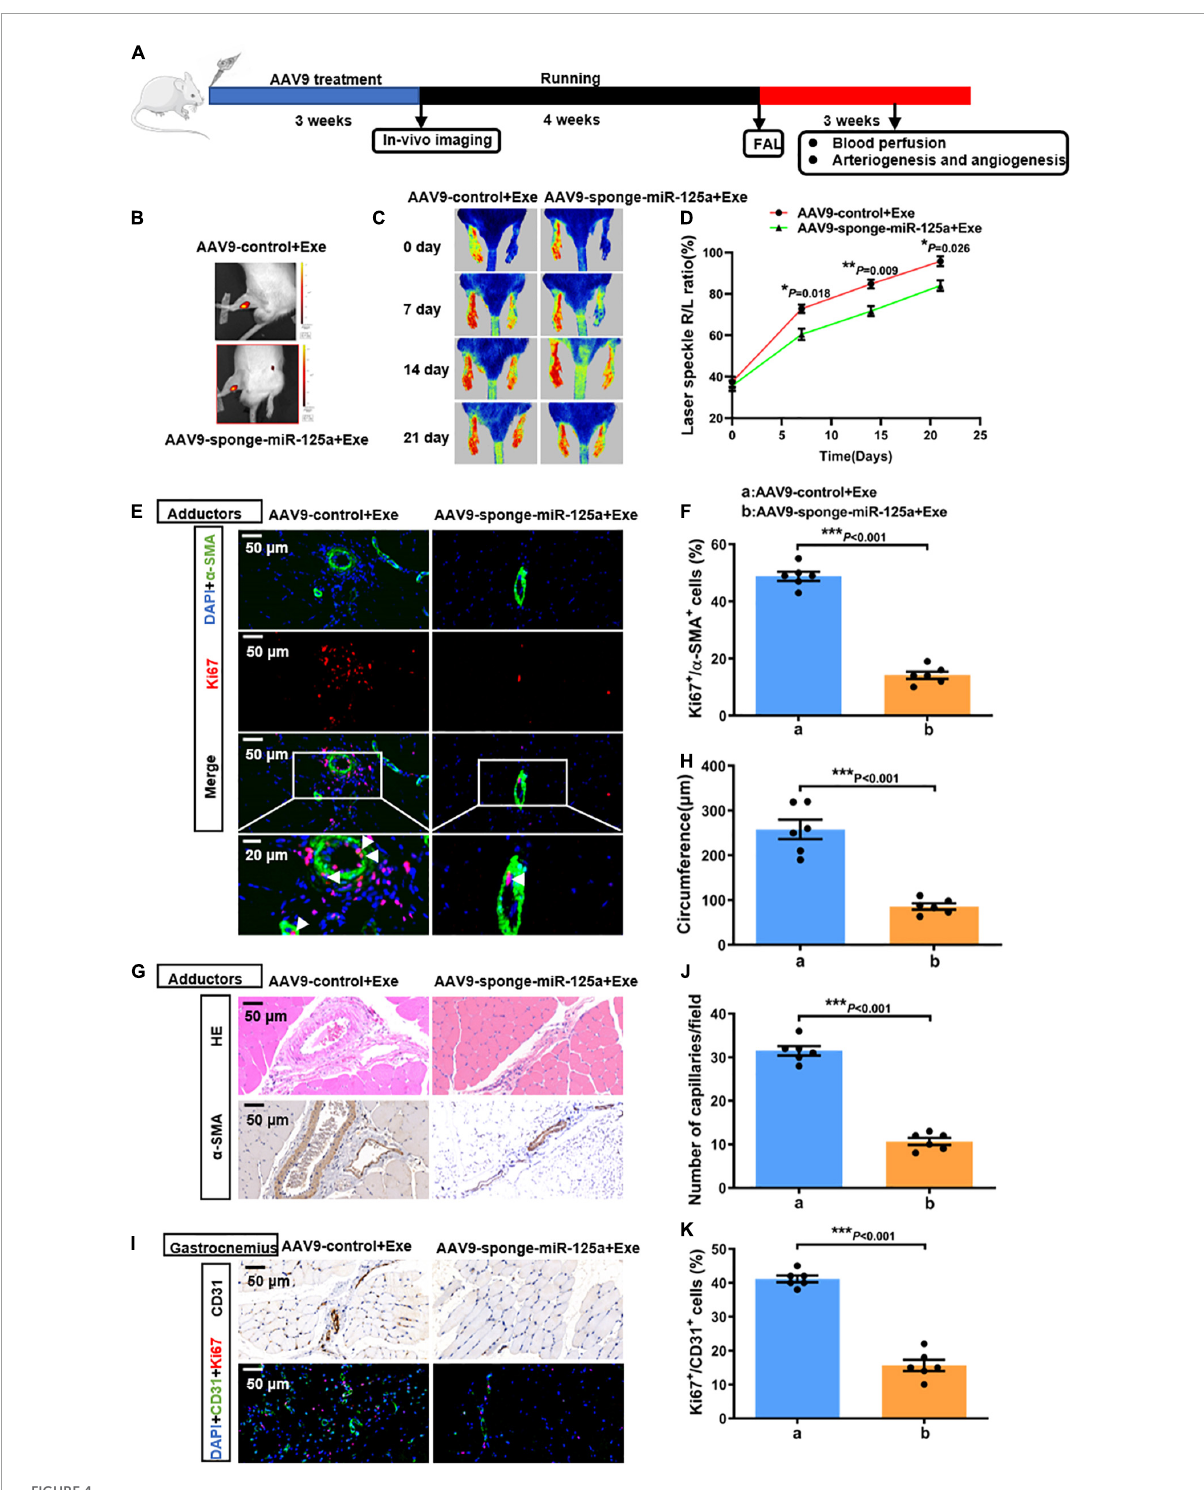
FIGURE4 miR-125a-5p was indispensable in exercise-induced arteriogenesis and angiogenesis in vivo . (A) Rats were randomly assigned to receive adductor injection in situ of either AAV9-sponge-miR-125a-5p-mCherry or AAV9-control-mCherry (1*10 12 vg/ml, 15 µ l/point, 5 points) per animal. After 3 weeks, the rats were subjected to in vivo imaging. Then the rats were subjected to 4 weeks of treadmill exercise training followed by FAL surgery, and hindlimb perfusion recovery was measured postoperatively on selected days via laser Doppler. (B) Representative in vivo images. (C,D) Representative laser speckle perfusion images (C) and a quantitative analysis (D) of the ratios of right to left (R/L) hindlimb perfusion among AAV9-control + Exe- and AAV9-sponge-miR-125a-5p + Exe- treated rats at indicated times after FAL. (E,F)